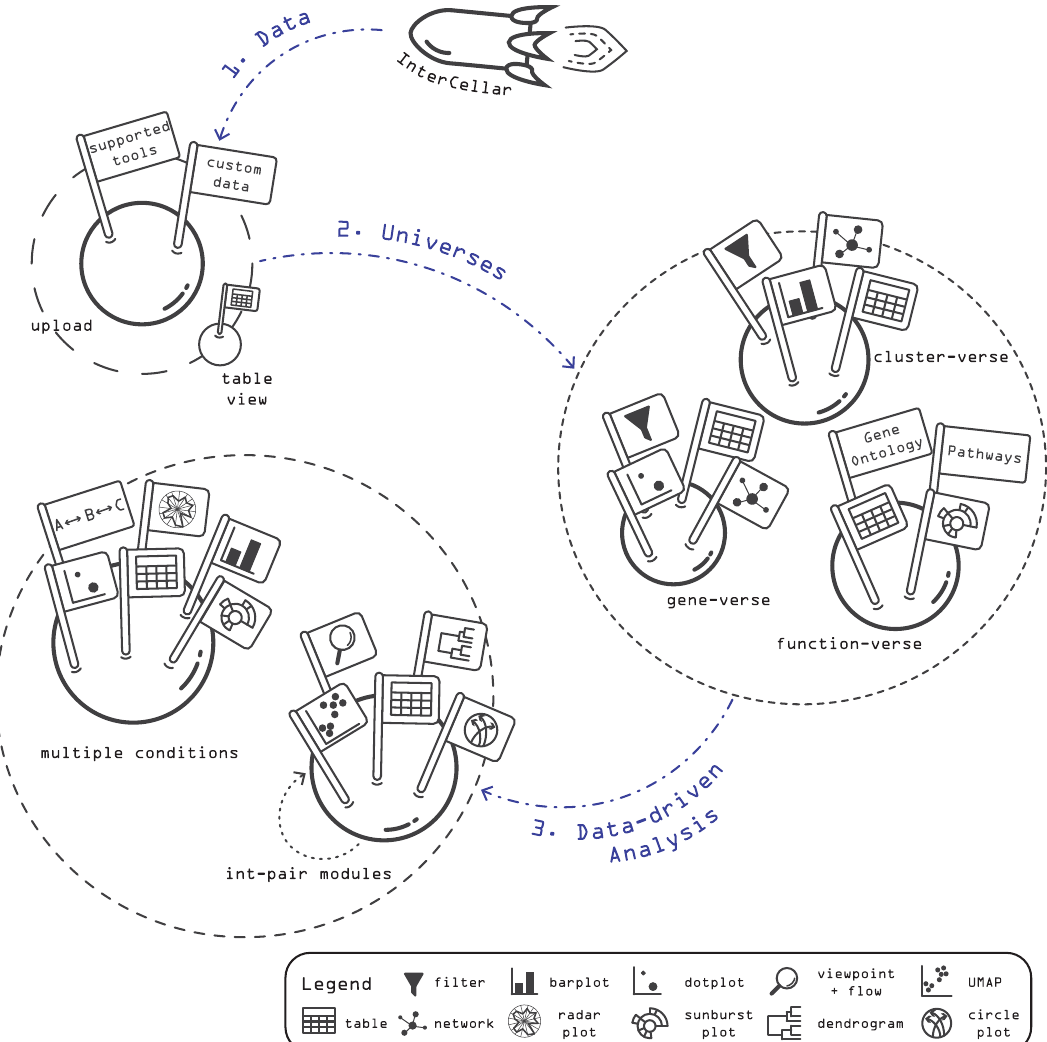
Fig. 1 Representation of InterCellar ’ s work fl ow. The analysis work fl ow is composed of three main steps: (1) upload of user-provided data, containing predicted, pre-computed cell − cell interactions (CCI data); (2) exploration of three biological domains (so-called, universes), whereby the analysis focuses on cell clusters, genes, and biological functions; and (3) data-driven analysis through the de fi nition and inspection of interaction-pair (int-pair) modules and the comparison of cell − cell communication from multiple conditions. For each step, fi ltering options (e.g., on cell clusters, genes, and functional databases) and multiple visualizations (e.g., networks, barplots, dotplots, circle plots, and sunburst plots) are provided to conduct a customized analysis. Moreover, all tables and fi gures can be saved in multiple formats, helping the interpretation of complex cell − cell interaction datasets and the fi nalization of publication- ready